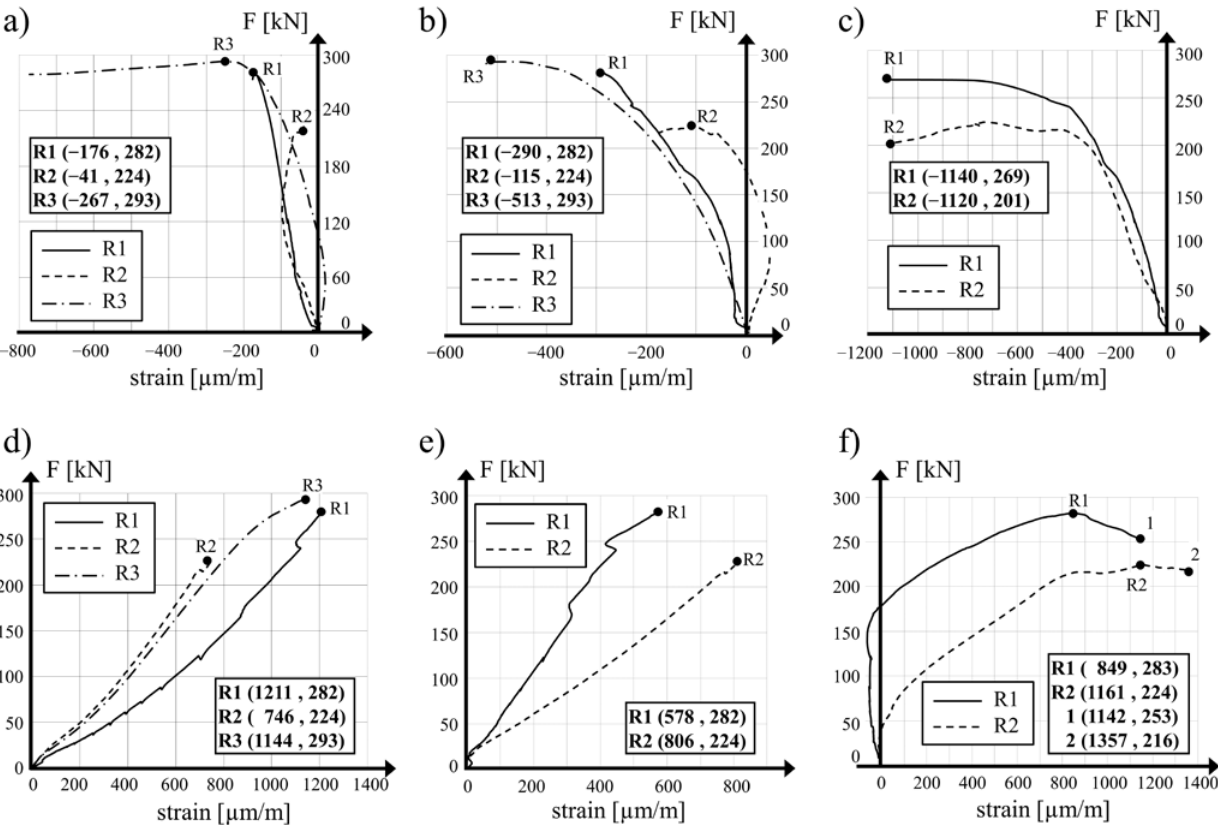
Figure 10. Vertical force vs. mean concrete strain in circumferential direction: ( a ) internal surface of hollow cylinders R1, R2 and R3 at their mid-height, ( b ) external surface of the cylinders at their upper measurement level, ( c ) external surface of hollow cylinders R1 and R2 at their bottom level of measurements. Vertical force vs. mean concrete strain in longitudinal direction: ( d ) internal surface of hollow cylinders R1, R2 and R3 at their mid-height points, ( e ) external surface of hollow cylinders R1 and R2 at their upper level of measurements and ( f ) external surface of hollow cylinders R1 and R2 in their bottom level of measurement.